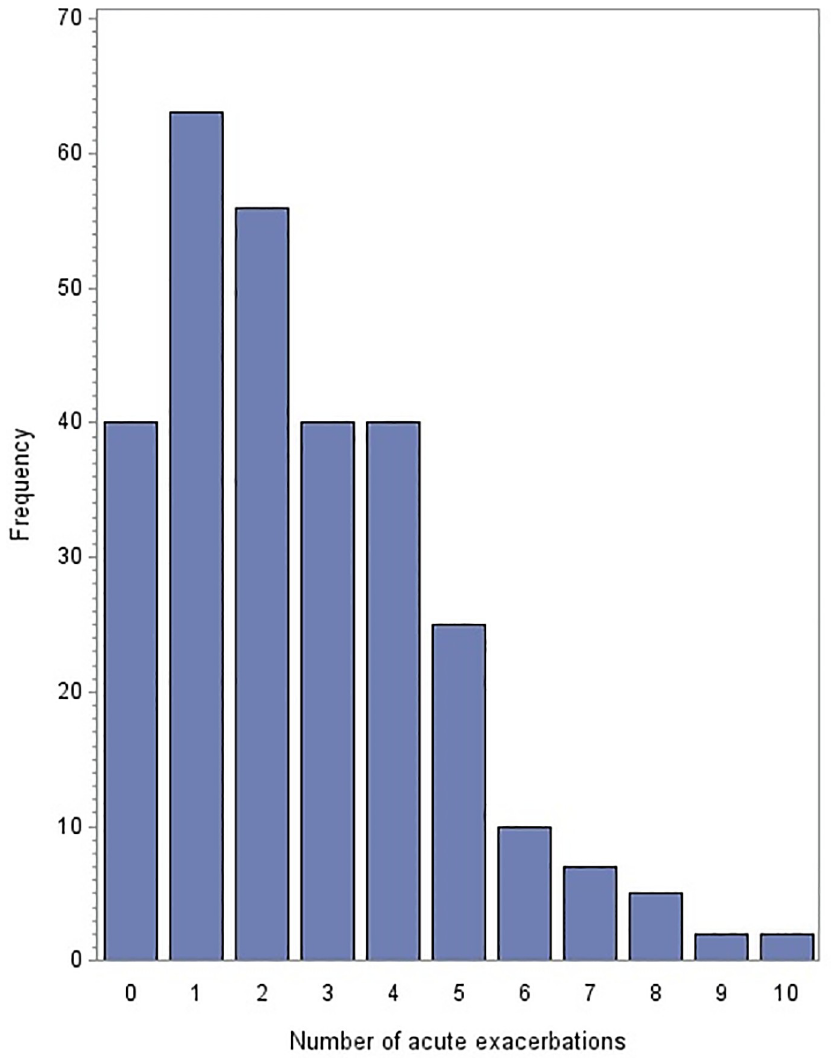
Fig 1. Distribution of all prospective acute exacerbations (mild-moderate-severe) in Cohort 3.